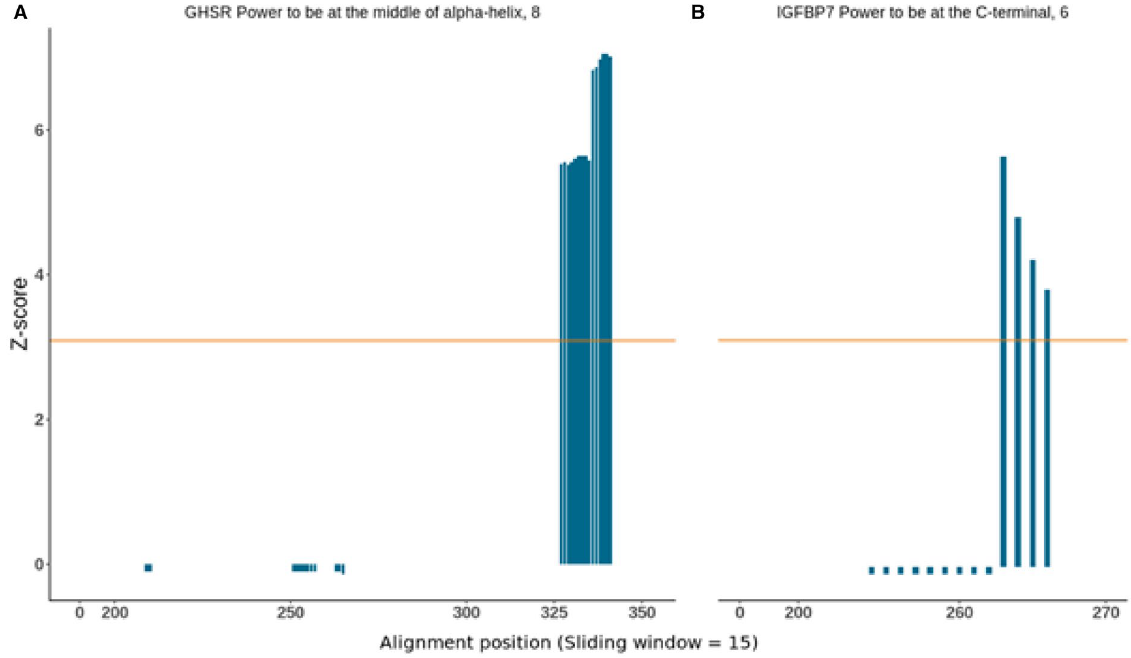
Figure 3. Detection of significant physicochemical amino acid changes using TreeSAAP and genes trees. This analysis was performed on the genes that presented higher ω values identified by codeML analysis in giant cetaceans. Only GHSR ( A ) and IGFBP7 ( B ) showed significant results. A highly significant z-score (z > 3.09, p < 0.01), represented here by the regions above the orange line, indicates more non-synonymous substitutions than assumed under the neutral model and therefore are interpreted as a result of positive selection. Respective property and category are shown above the environments, while all other animals had threonine (T), which is polar and highly soluble in water. This modi- fication is important because glycine is considered a "helix breaker" once it disrupts the regularity of the α helical backbone conformation since it lacks a β carbon, which is associated with more conformational freedom than other residues 47,48 . As mentioned before, the results reinforce that large phenotypes may evolve by different paths. It is worth noting that changes in specific species, such as the different site in the sperm whale—the only odontocete classified as a giant, may be related to characteristics of that species, involving the large body size or other characteristics affected by the gene. GHSR is an endogenous ligand that can stimulate, through its ghrelin ligand, the release of growth hormone through the pituitary gland and thus increase appetite, regulate body weight, energy metabolism, and fat accumulation 49 . In addition, it is associated with the secretion of gastric acid, control of cell proliferation, apoptosis, lactation, and cardiovascular pressure 50–52 . This gene has been linked to increased body size in cattle, sheep, and pigs 30,53–55 . In most cases, the increase in body size in these animals results from changes in a few sites, but these changes were not found in giant cetaceans. Nevertheless, this may indicate that minor changes in this gene can result in phenotypic modifications. IGFBP7 is a 27 kD protein and a member of the IGFBP superfamily, responsible for the viability of insulin- like growth factors (IGFs)—molecules involved in promoting cell growth and division 56 . Evidence suggests that IGFBP7 acts as an oncosuppressor gene in prostate, breast, lung, and colorectal cancer due to its regulatory action related to cell proliferation, cell adhesion, cell senescence, and angiogenesis 57,58 . This repressor activity may arise